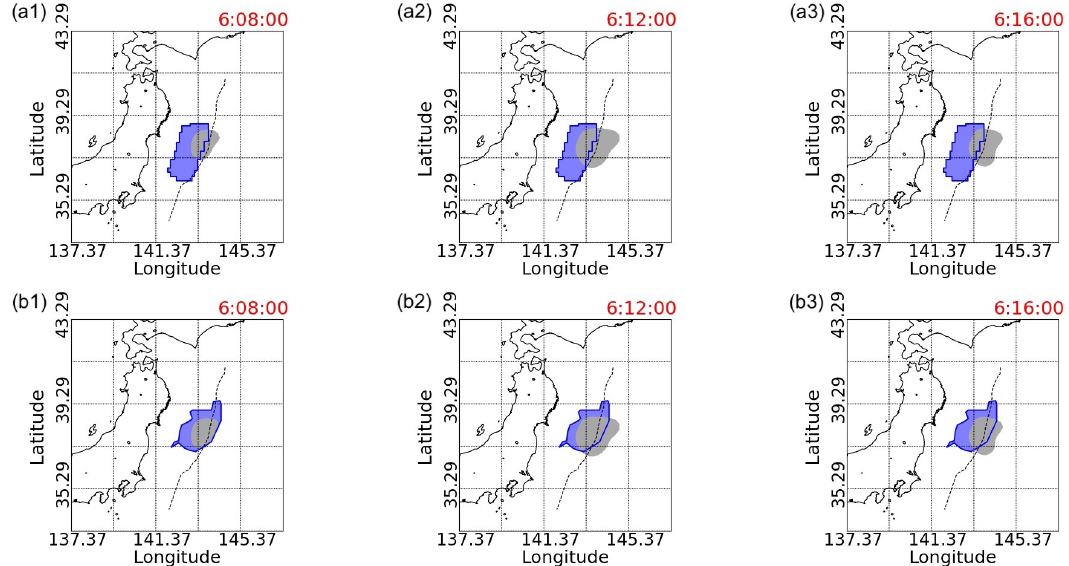
Figure 12. TIH and the initial-tsunami comparison. In the first row, the initial tsunami estimated by Ohta et al. (2012) is shown. In the second row, the initial tsunami estimated by Takagawa and Tomita (2012) is shown. In both cases, the TIHs with TEC values less than − 4 are